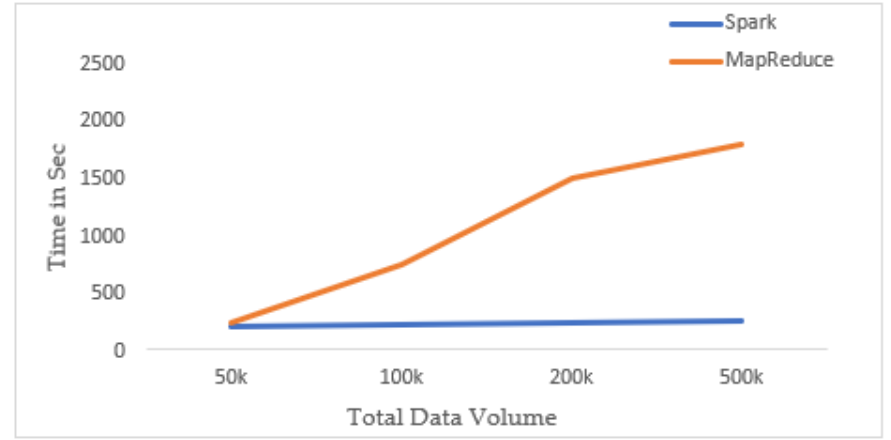
Figure 4. Performance on skyline